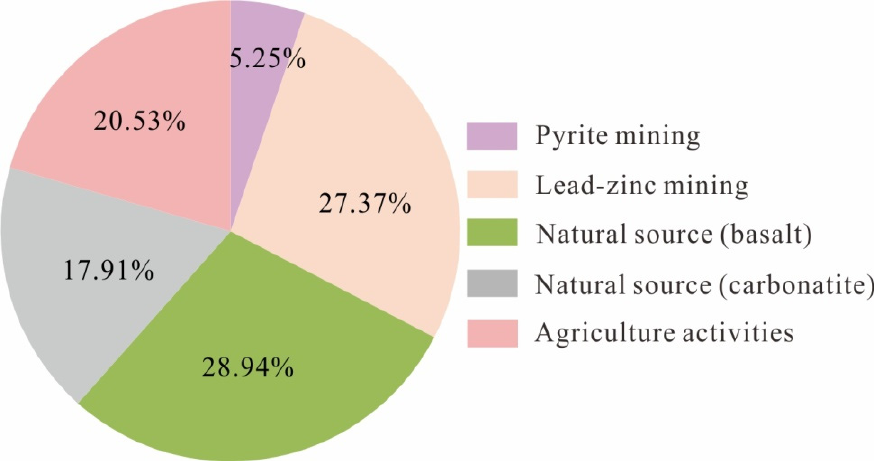
Figure 4. Factor contributions of potential ecological risk.